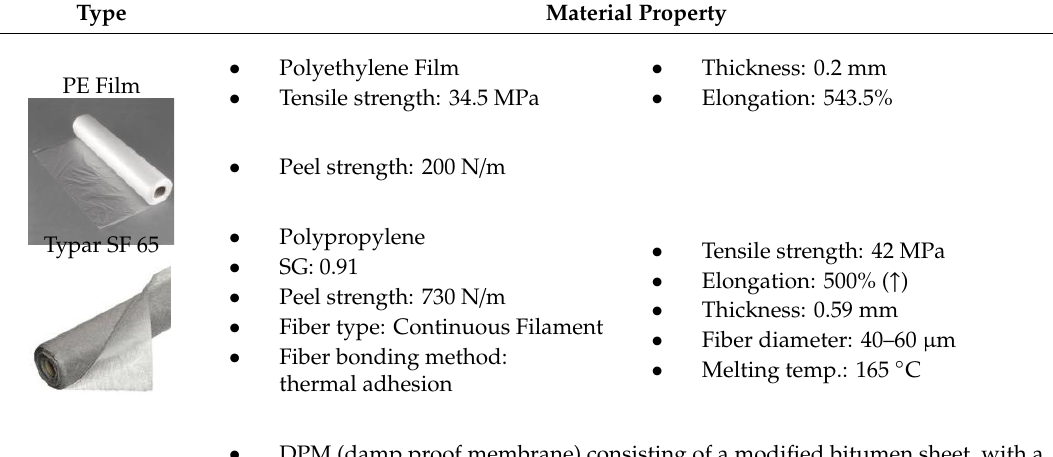
Table 2. Material property of the water-resistant layer.